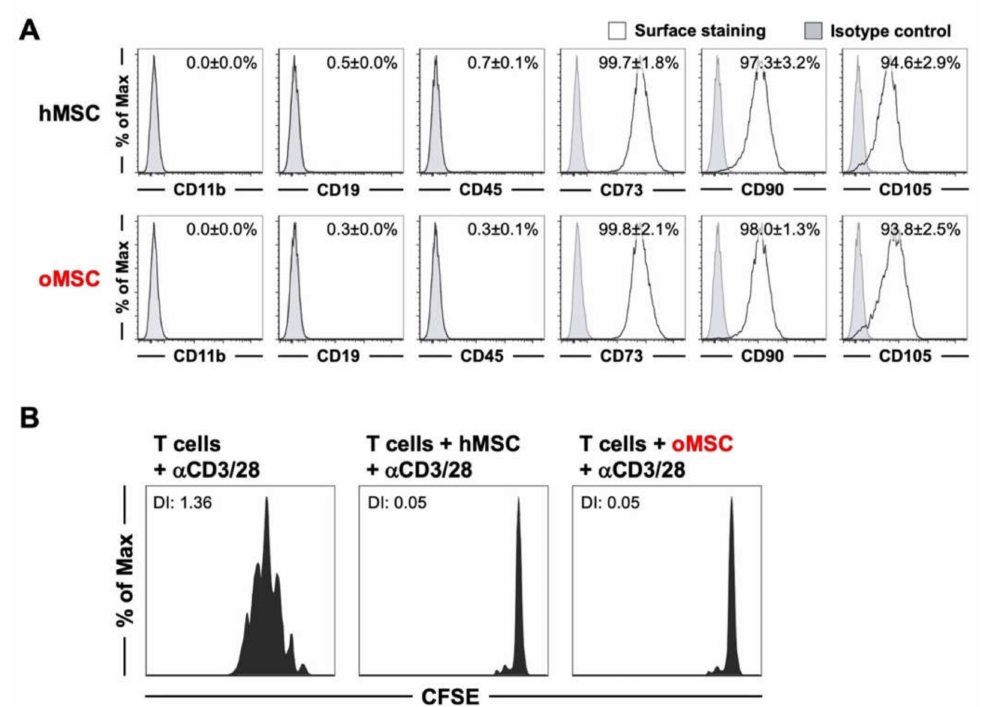
Figure 2. Mesenchymal stromal cells (MSC) of healthy control donors (hMSC) and osteoporotic donors (oMSC) exhibited comparable surface marker expression and immune-modulatory capacity. ( A ) Flow cytometric surface marker expression analysis of MSCs from osteoporotic and non-osteoporotic donors at passage 3–4. The percentage of positive cells is indicated in the top right corners. ( B ) hMSCs and oMSCs were tested for their immunomodulatory capacity by suppressing the proliferation of CD8 + T cells. Carboxyfluorescein succinimidyl ester (CFSE)-labeled human CD8 + T cells were stimulated with α CD3 / 28-coated beads in the absence or presence of hMSCs or oMSCs, and proliferation profiles were flow cytometrically analyzed. Division index (DI) as a measure of cell proliferation is depicted in the top left corners. Data are expressed as average ± SD of five donors per